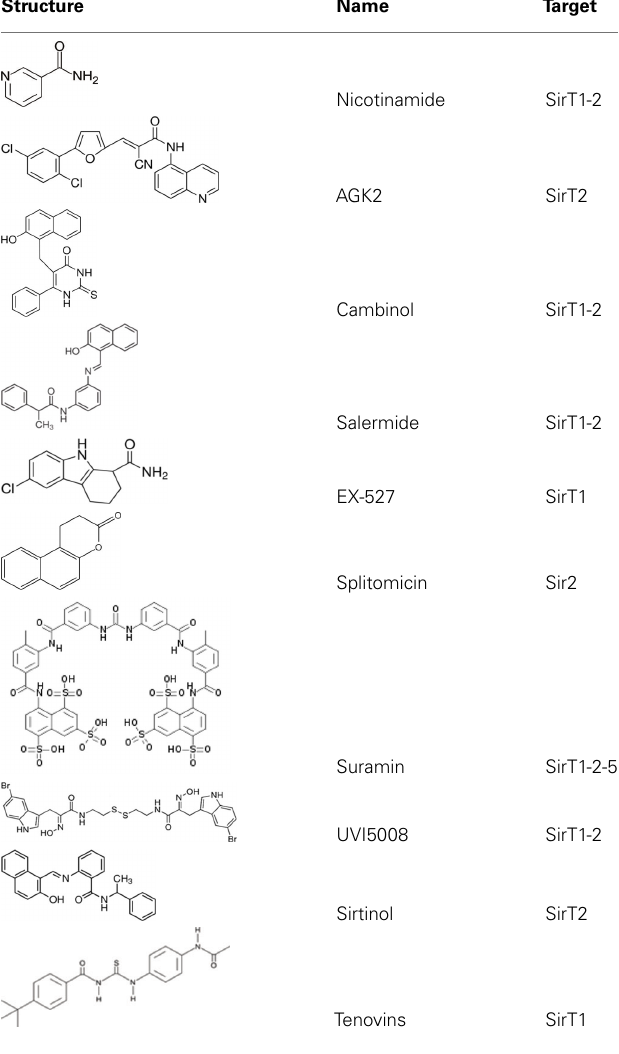
Table 2 | Sirtuin